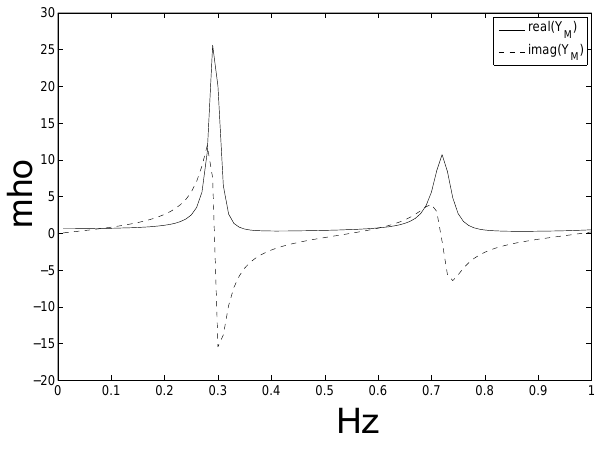
Fig. 3. Magnetospheric admittance computed from the transmission line model, using the parameters of Fig.